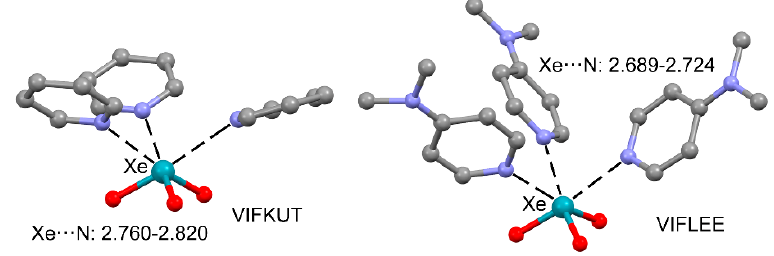
Figure 14. Aerogen bonging interactions in two XeO 3 adducts (CSD refcodes VIFKUT and VIFLEE [77]). Aerogen bonds are represented as black dashed lines.